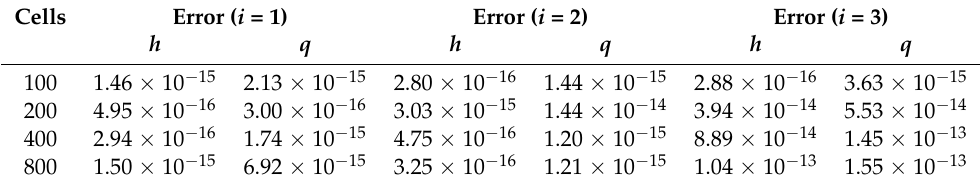
Table 10. Test 3.1. Differences in L 1 -norm with respect to the stationary solution for CLWBM i , i =